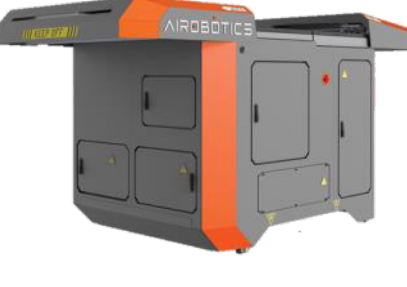
Figure 5. Airobotics Drone Base (Israel)